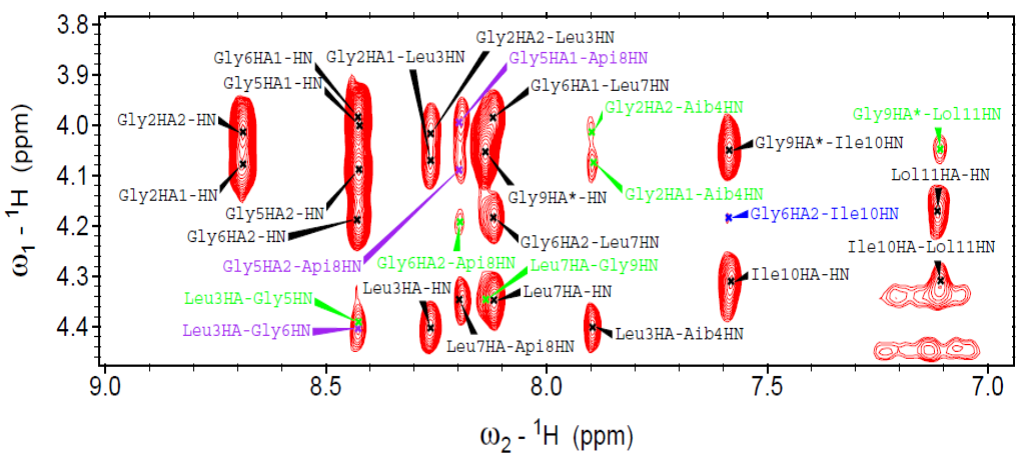
Figure 8. NH amide region of the NOESY spectrum acquired for peptide 8 (600 MHz, 100 mM